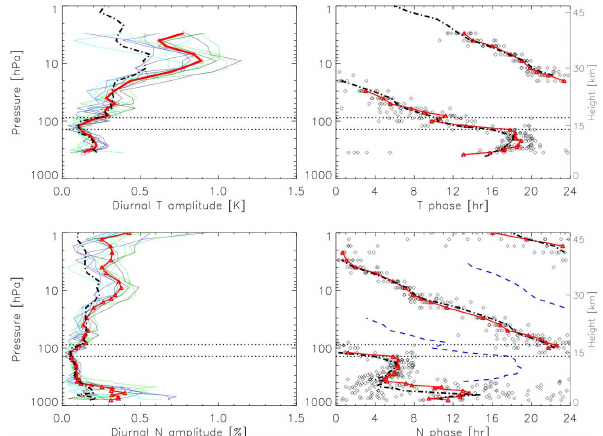
Fig. 17. Vertical structure of temperature and refractivity ampli- tudes (left panels) and phases (right panels) of diurnal variations over 10 ◦ S–10 ◦ N based on COSMIC RO observations in 2007. Each solid line in the left panels represents one monthly mean am- plitude profile whereas phases from the monthly data are shown as open diamond in the right panels. The four seasons are denoted by different colors, e.g., DJF (green), MAM (blue), JJA (cyan), SON (black). The RED thick lines show the annual median values. The blue dashed lines in the lower right panel represent the temperature phase as shown in the upper right panel. The black dash-dot lines in all four panels correspond to the annual median-averaged results in 2007. The two black thin dashed lines in each panel mark altitudes at 14km and 17km, respectively (Xie et al., 2010).